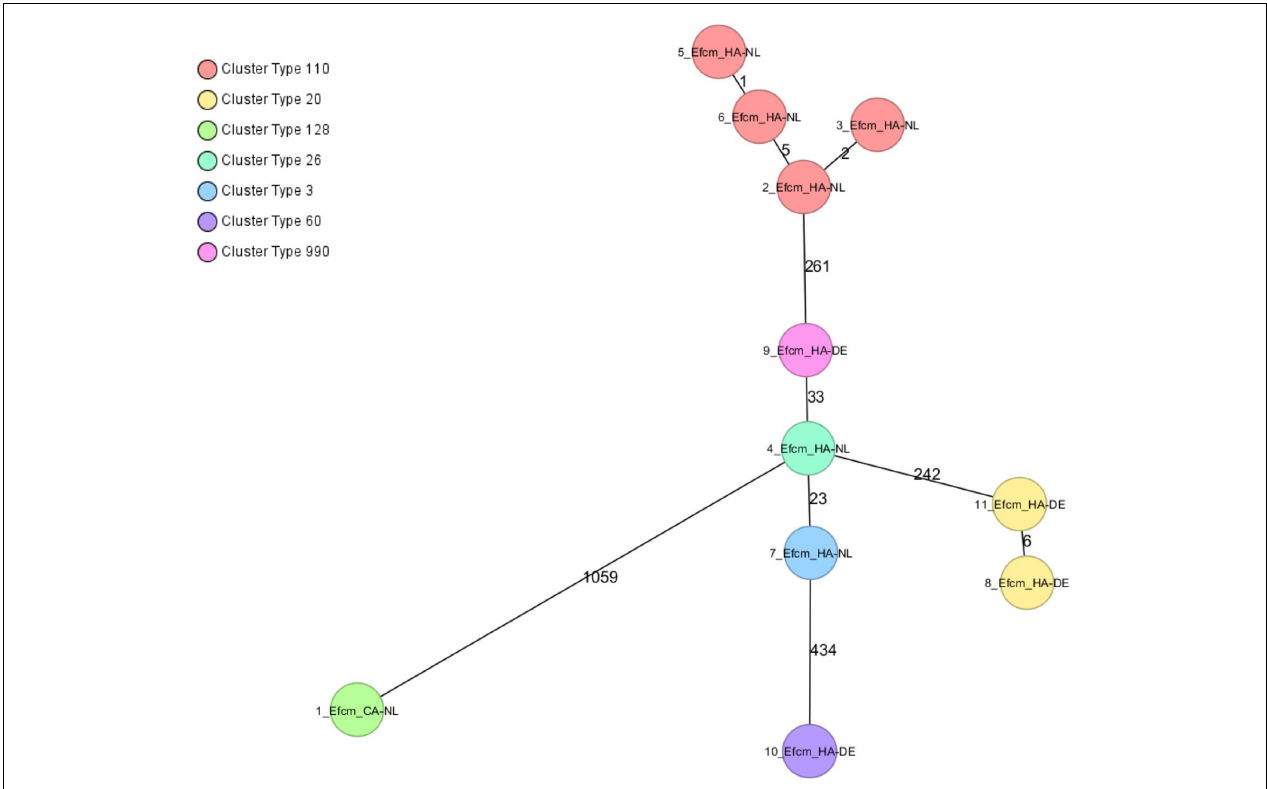
FIGURE 2 | Minimum spanning tree of VREfcm, cgMLST based on 1423 genes using the parameters “pairwise ignoring missing values” during distance calculation. Each circle represents a genotype and colors indicate cluster types (CT). Number of different alleles are indicated on the edges between connected isolates (nodes). Isolates are presented by their ID, ST, and